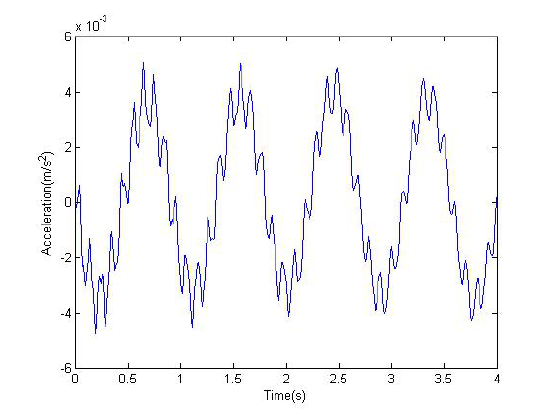
Force identification: (a) using only one order model (b) using three order